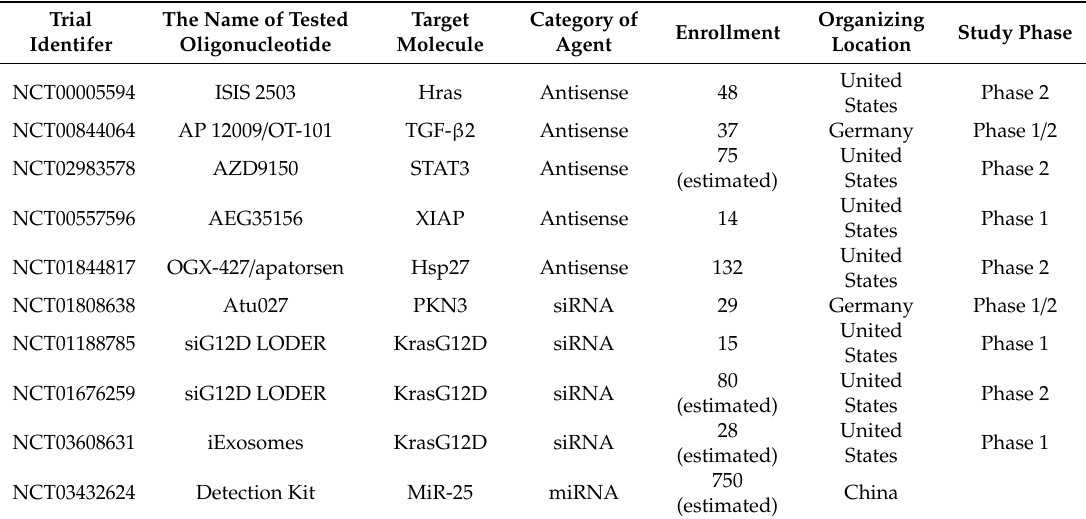
Table 1. Clinical trials of Oligonucleotide therapeutics for patients with pancreatic